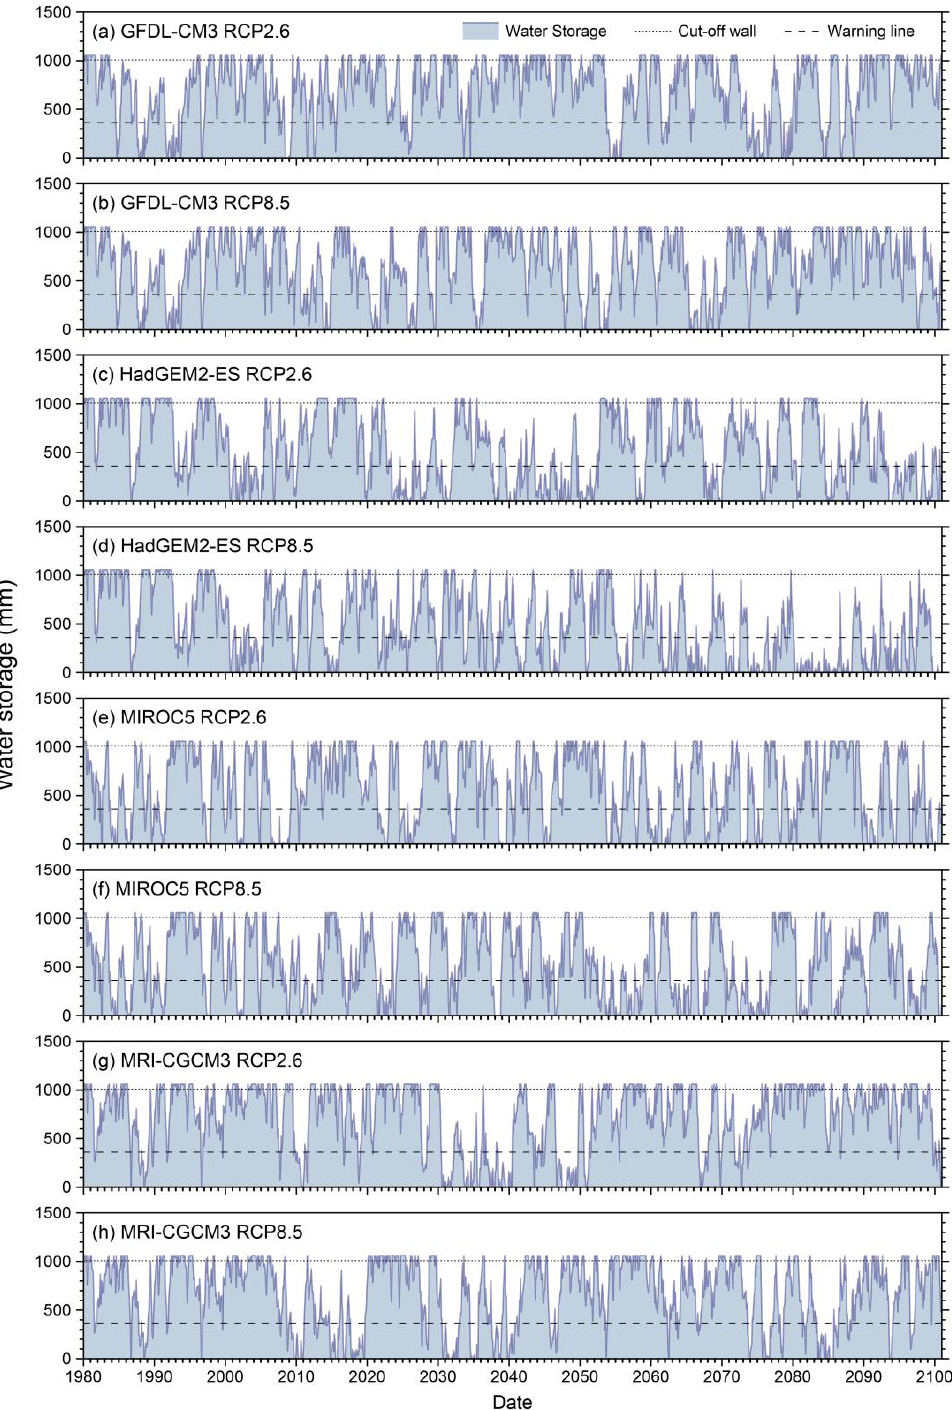
Figure 11. Time series of estimated water storage for four GCM (GFDL-CM3, HadGEM2-ES, MI- ROC5, and MRI-CGCM3) models under two GHG emission scenarios (RCP 2.6 and RCP 8.5) for the period 1980‒2100.